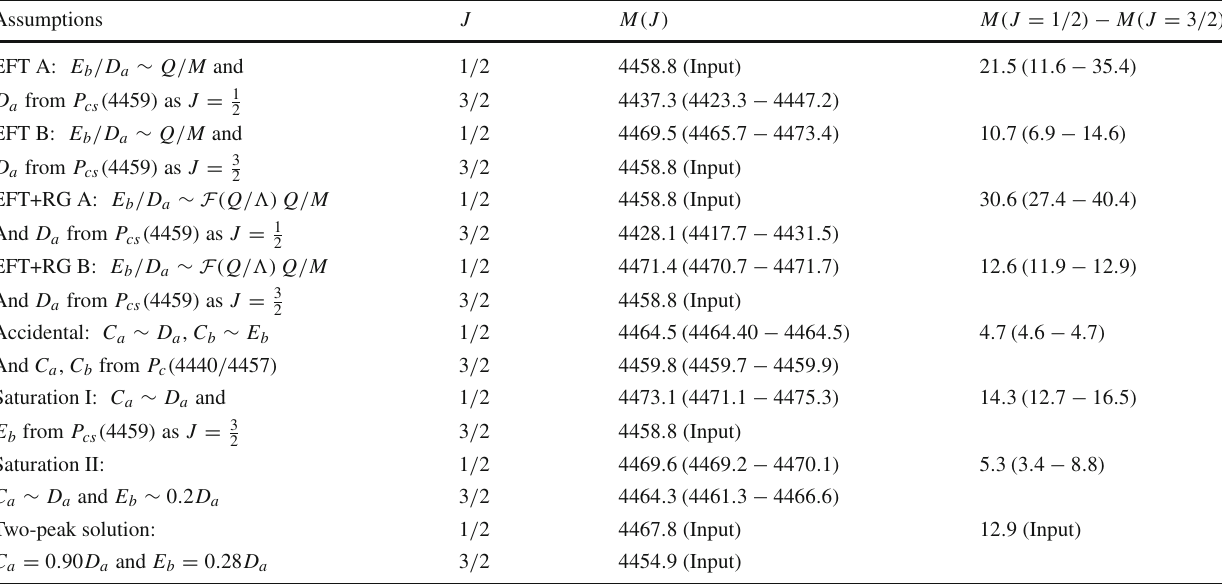
¯ D (cid:3) (cid:3) ¯ D ∗ (cid:3) ¯ D ∗ (cid:3) ¯ D (cid:3) ∗ = 3 c and J c - c - c pentaquarks 2 2